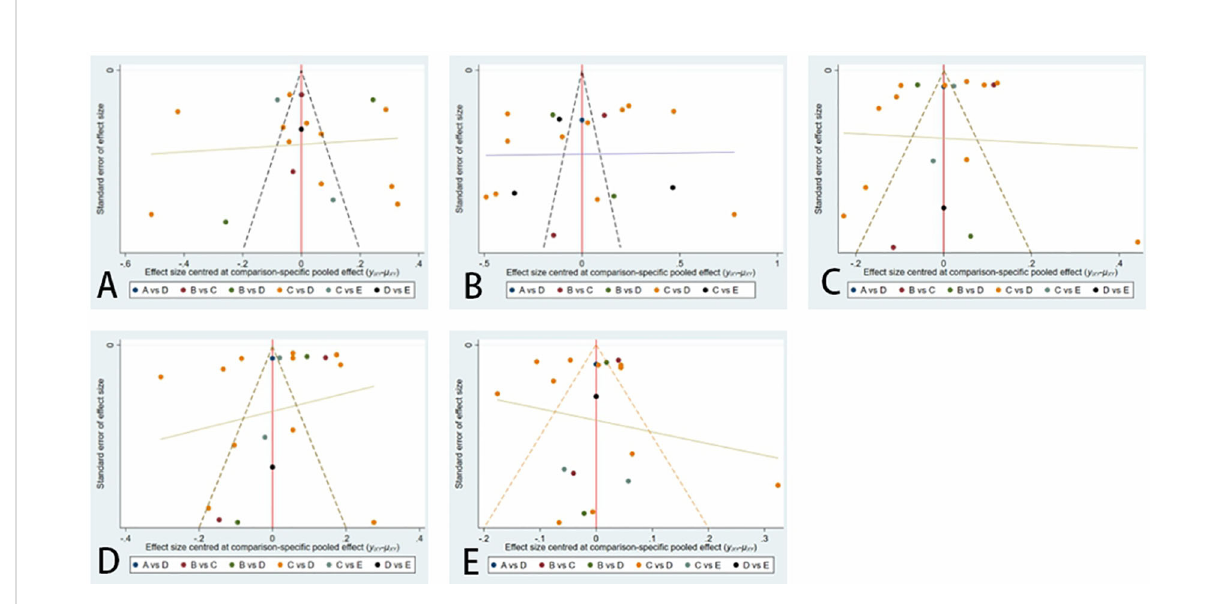
FIGURE 8 Funnel plot on publication